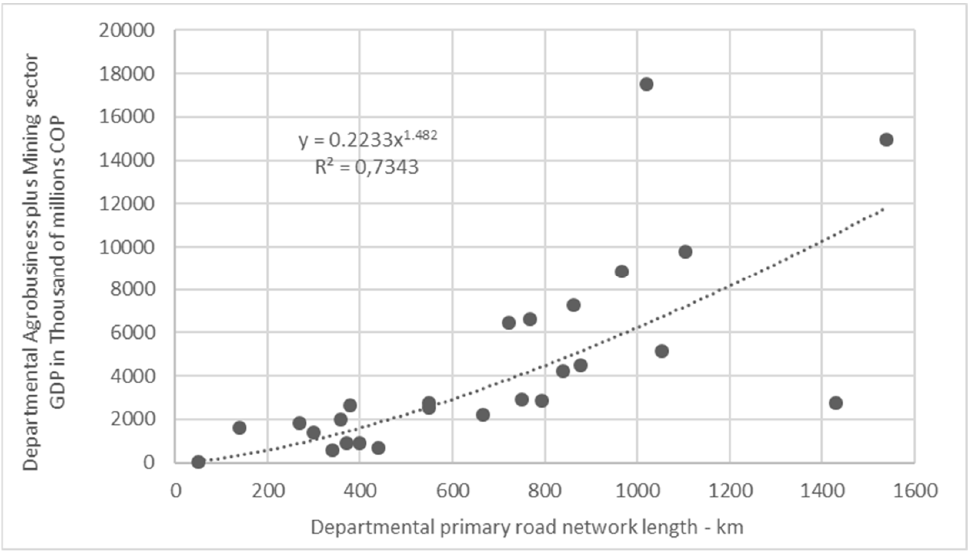
Figure 8. Potential regression between agribusiness plus mining sector GDP and primary roadway network, according to the department.